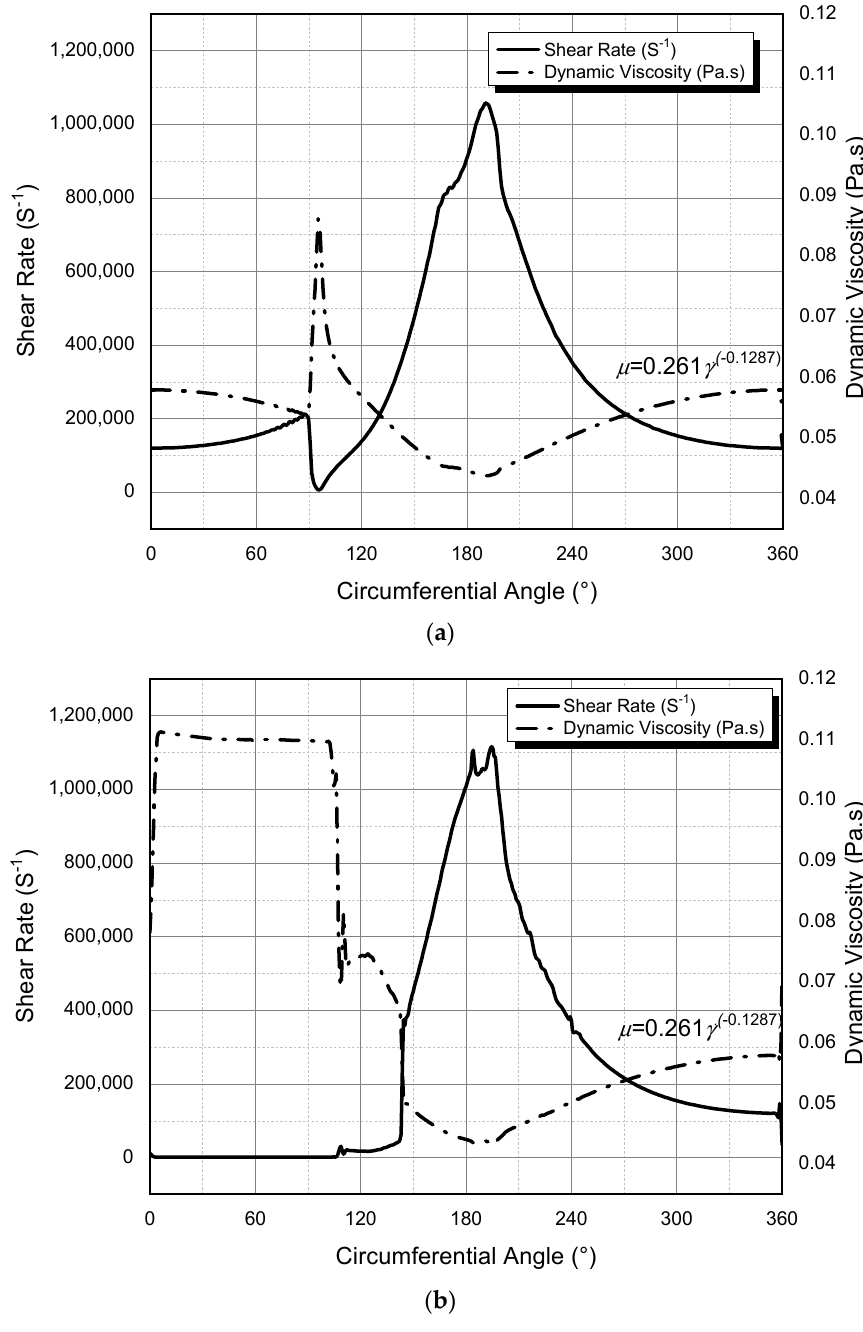
Figure 6. Shear rate and dynamic viscosity of liquid phase in the case of ( a ) no-slip; ( b ) engineered heterogeneous slip/no-slip for bearing lubricated by non-Newtonian fluid. The numerical results are evaluated at mid-plane z/ L of 0.5, rotational speed of 4000 rpm, and eccentricity ratio ε of 0.8.